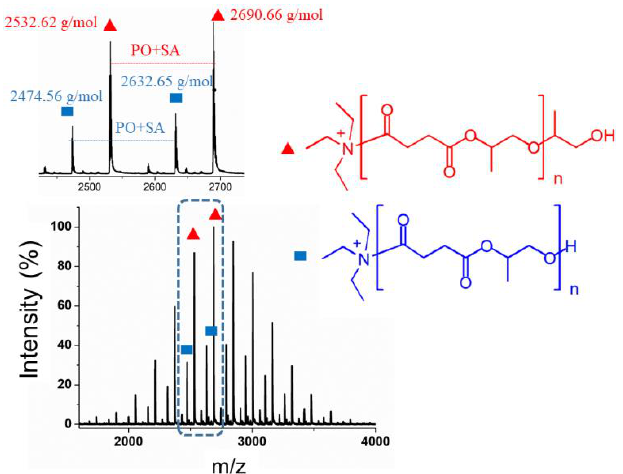
(TEB)/TEA (entry 2, Table 1); (4) TEB/TEEA (entry 4, Table 1).